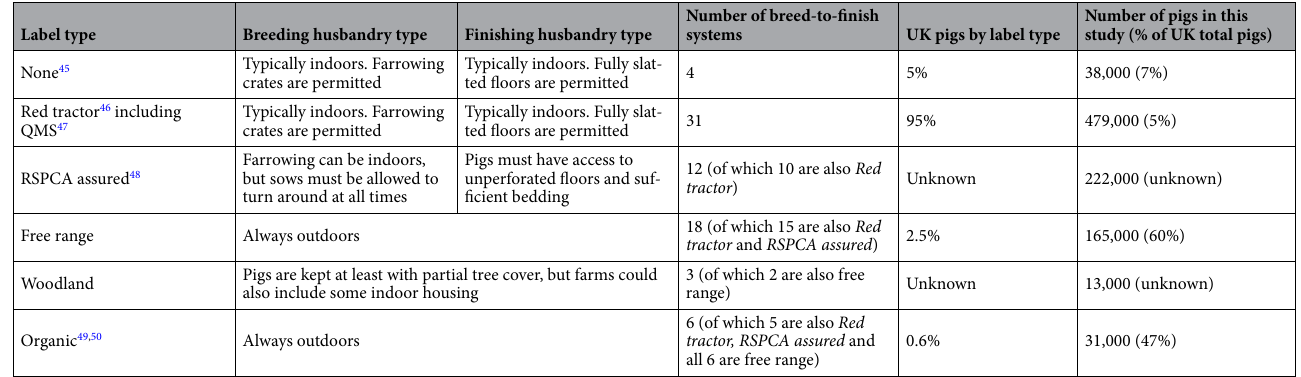
Table 1. Description of the 74 breed-to-finish pig systems studied. If systems met the requirements for multiple label types, they were included in the highest relevant type (see Supplementary Figure S7 for a Venn diagram illustrating the overlapping label types for our 74 studied systems). Any relevant standards or guidelines can be found in the citations in the first column and relevant extracts of the standards can be found in Supplementary Table S2. Note that free range and woodland do not have specific guidelines in the UK. The UK pigs by label type column shows the percentage of the total slaughtered fattening pigs in the UK in 2021 43 with each label type 44 . These sum to more than 100% as farms can have multiple label types. The pigs in this study column shows the annual slaughtered fattening pigs from our 74 systems, summed by label type, and rounded to the nearest 1000, and our estimate of the % of all UK slaughtered pigs belonging to that label type which they represent. In total, our study covers 5% of UK slaughtered fattening